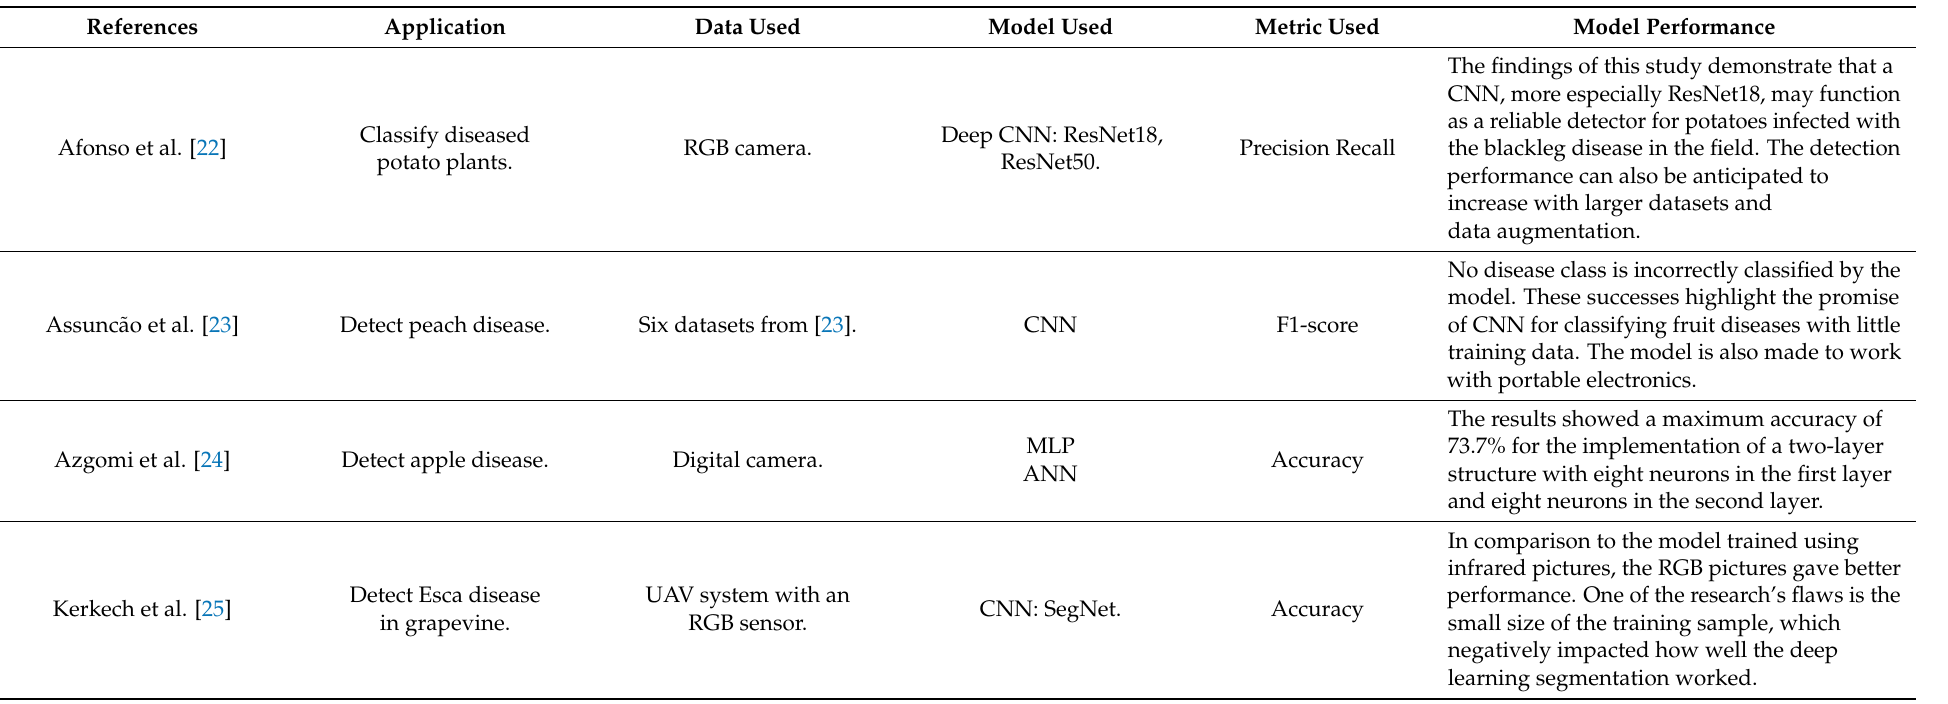
Table 3. Feature descriptions of publications in the field of “Disease